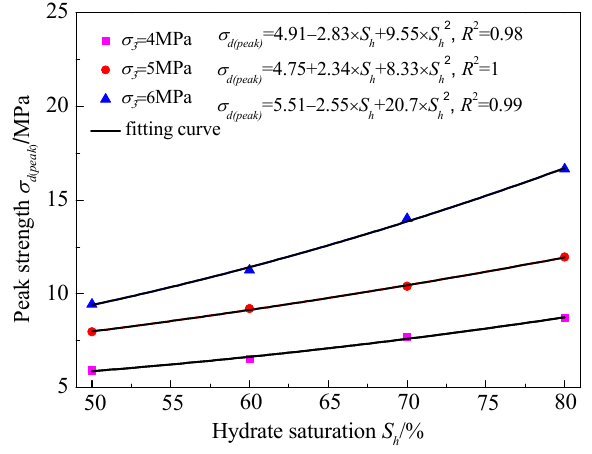
Figure 8. Variation of the peak strength with the hydrate saturation.